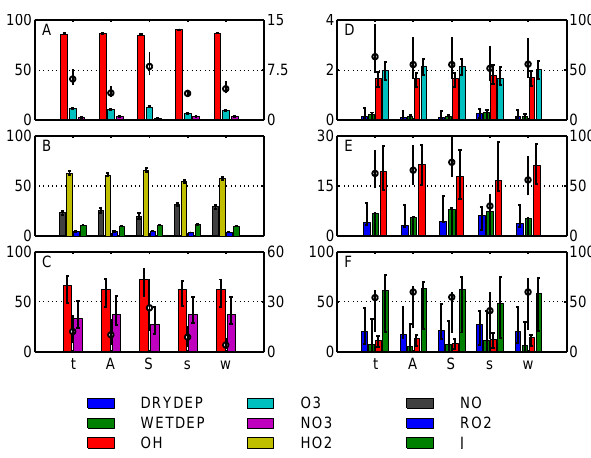
Fig. 2. Overview of the isoprene photochemical cascade (thick color bars) for the reference simulation in different regions (Tropics (t), Africa (A), South America (S), Southeast Asia (s) and World (w)). Branching ratios for the reference run (in percent) are indi- cated by bars for isoprene oxidation (A, left axis), isoprene per- oxy radical fate (B, left axis), isoprene nitrate sources (C, left axis), ING 0 fate (D, right axis), ING 1 fate (E, right axis), ING 2 fate (F, right axis). Black open circles indicate the lifetime (in hours) of isoprene (A, right axis), ING 0 (D, left axis), ING 1 (E, left axis) and ING 2 (F, left axis), and the fractional loss of NO x caused by isoprene nitrate chemistry, D ING / L NO (C, right axis in %). The x extent of the error bars represents the minimum and maximum val- ues calculated using the different representations of isoprene nitrate chemistry. J designates the isomerization of isoprene peroxy radical (B, Peeters et al. (2009)) or the photolysis of ING 2 (F).